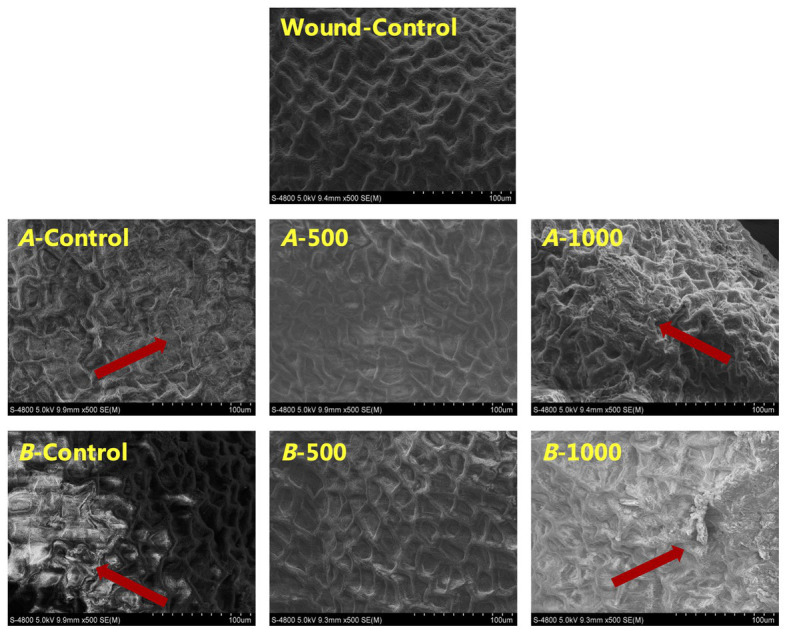
Scanning electron microscope (SEM) images of fruit cells of A. alternata- and B. cinerea-inoculated blueberry after treatment with ethanol on the 8th day of storage at 0±0.5°C. The scale bars represent 100μm.